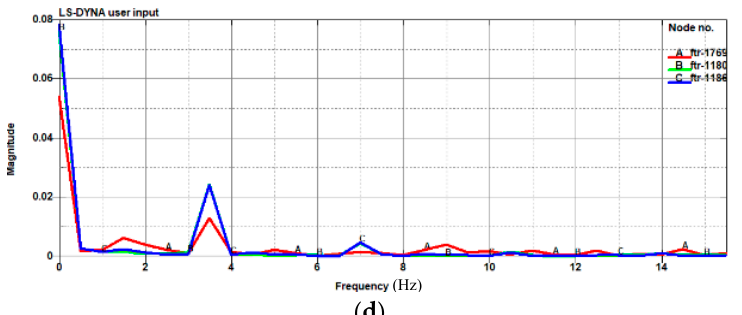
Figure 14. The displacement vs. time and correspondent result of FFT, P13, and P23. ( a ) The displacements of points at the condition P21. ( b ) The corresponding result of FFT at the condition P21. ( c ) The displacements of points at the condition P23. ( d ) The corresponding result of FFT at the condition P23.